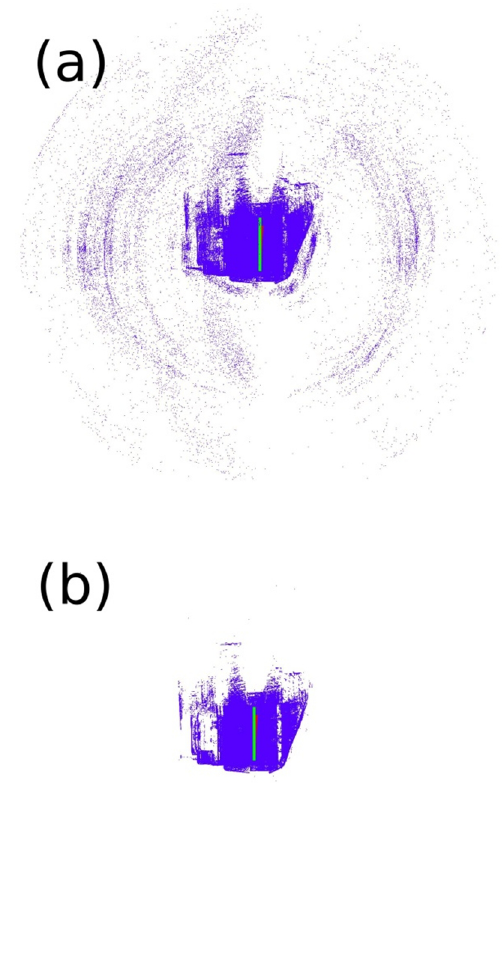
Figure 3. (a) Unfiltered point cloud vs. (b) filtered point cloud visualized from the top. Almost all of the outliers vanish in